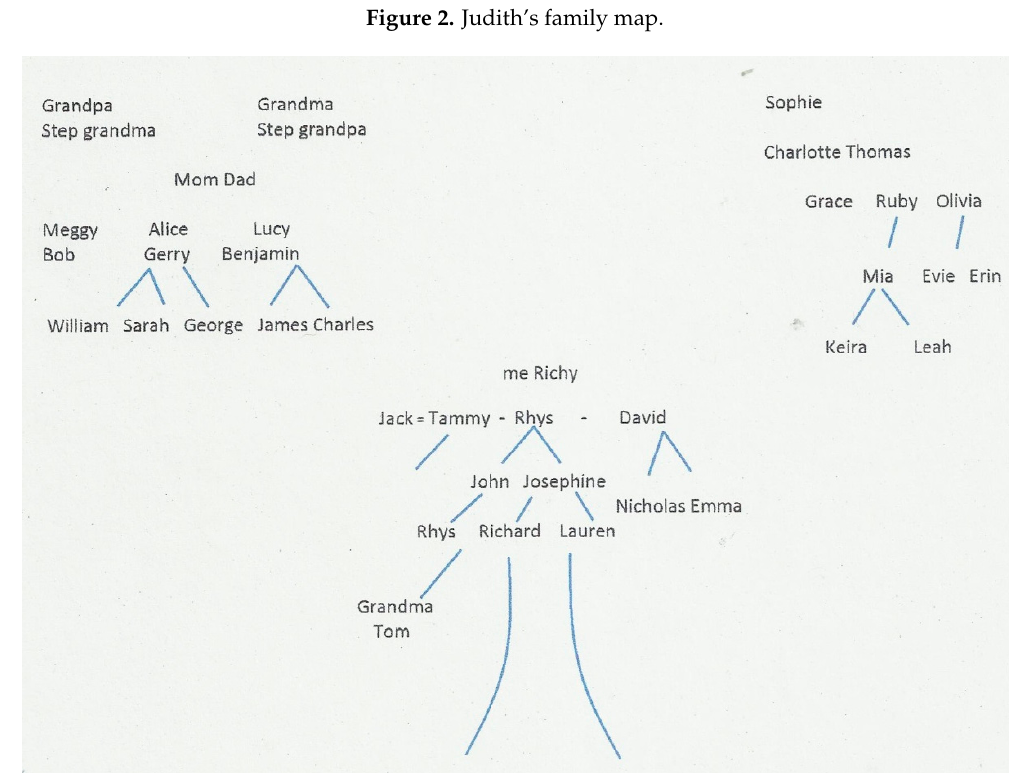
Figure 3. Melissa’s family map.